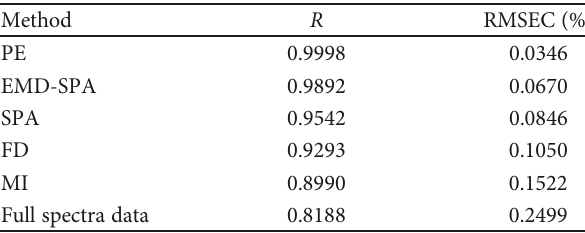
Table 2: R and RMSEP of SVR model.